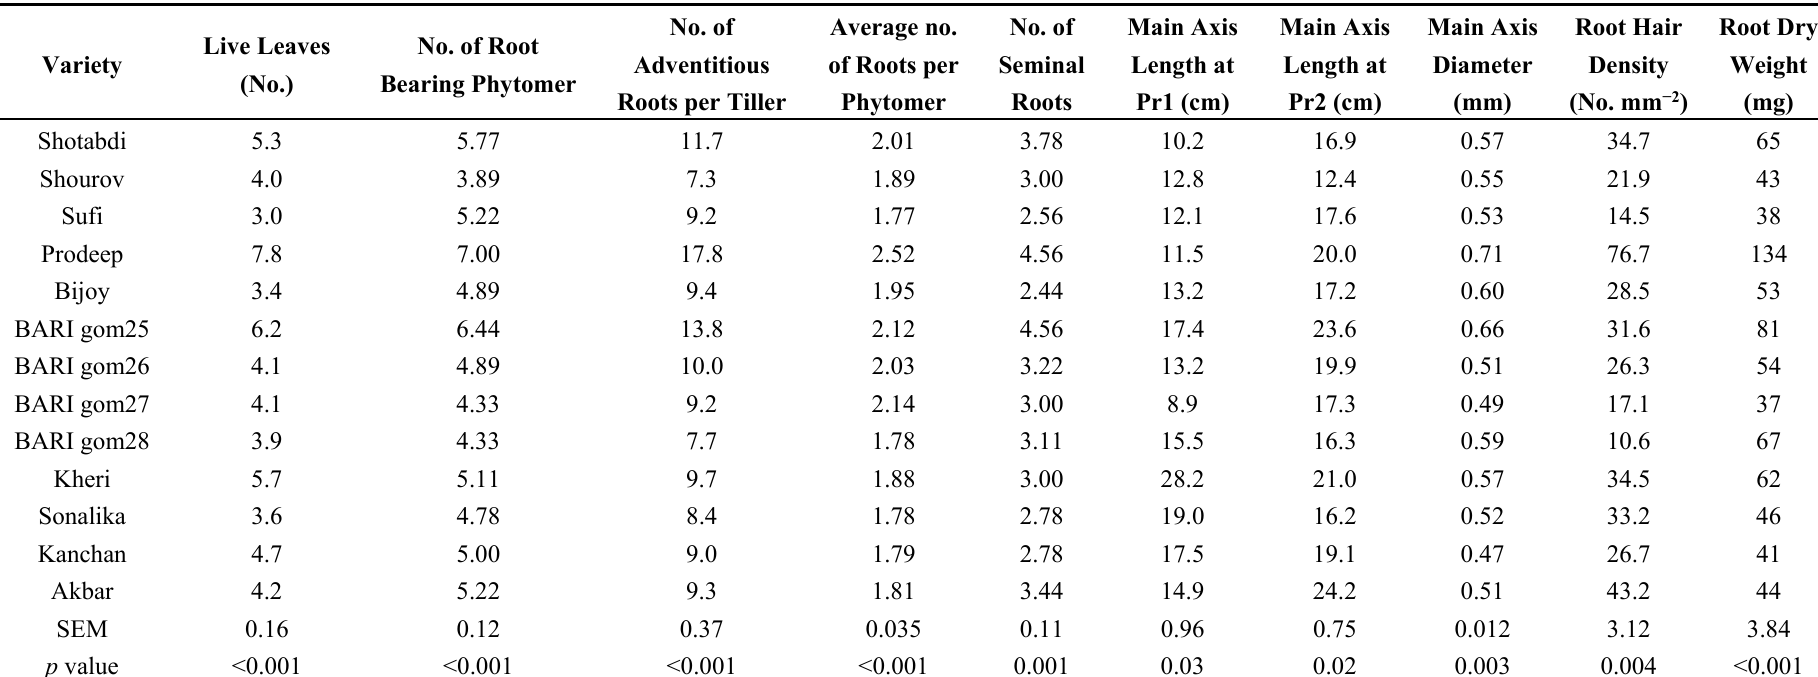
Table 3. Variation in different morphological characters of 13 wheat varieties on 20 days after PEG- treatment (DAT). Data represents average of nine replicates on 12 DAT from three treatments. Pr, root bearing phytomer; SEM, standard error of mean; p , statistical significance.